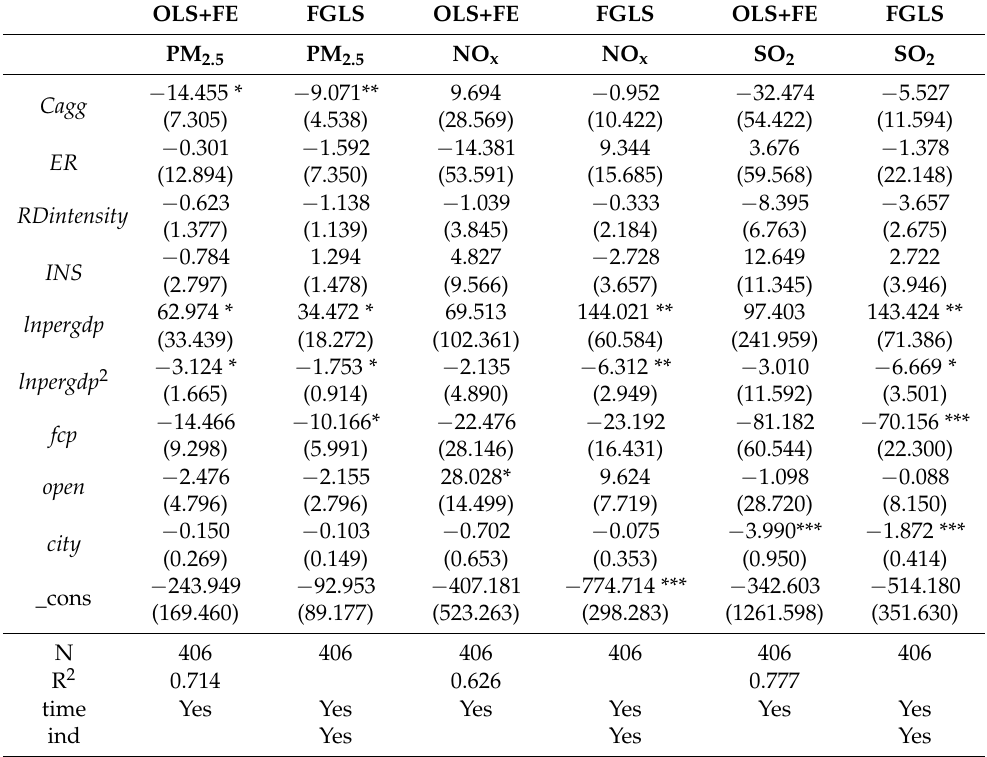
Table 5. Baseline regression of the effect of co-agglomeration on air